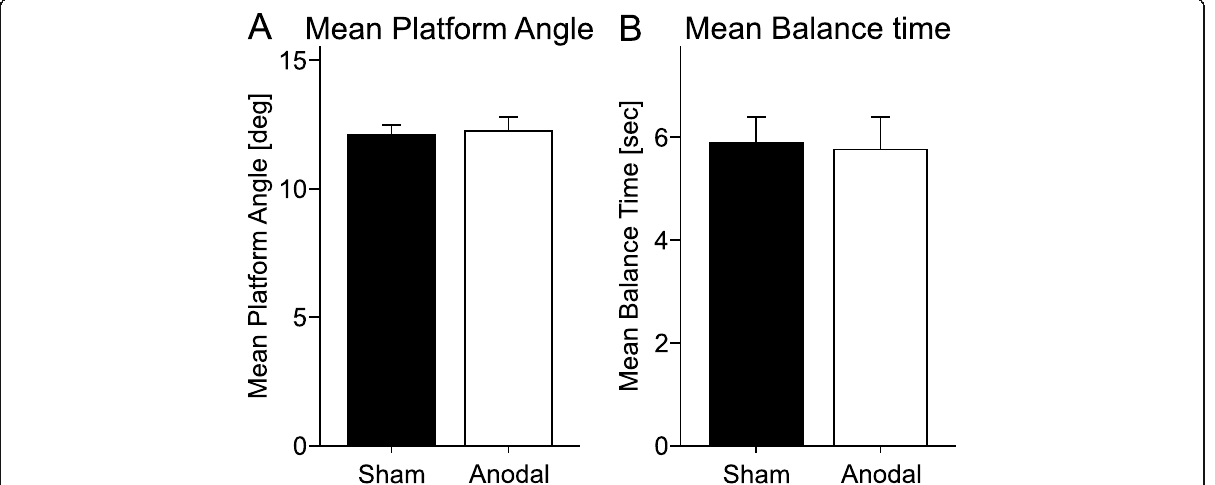
Fig. 3 Test trial with no stimulation applied. Mean platform angle and standard error of the mean, and mean balance time and standard error of the mean in the test trial in each stimulation group (verum vs. sham)